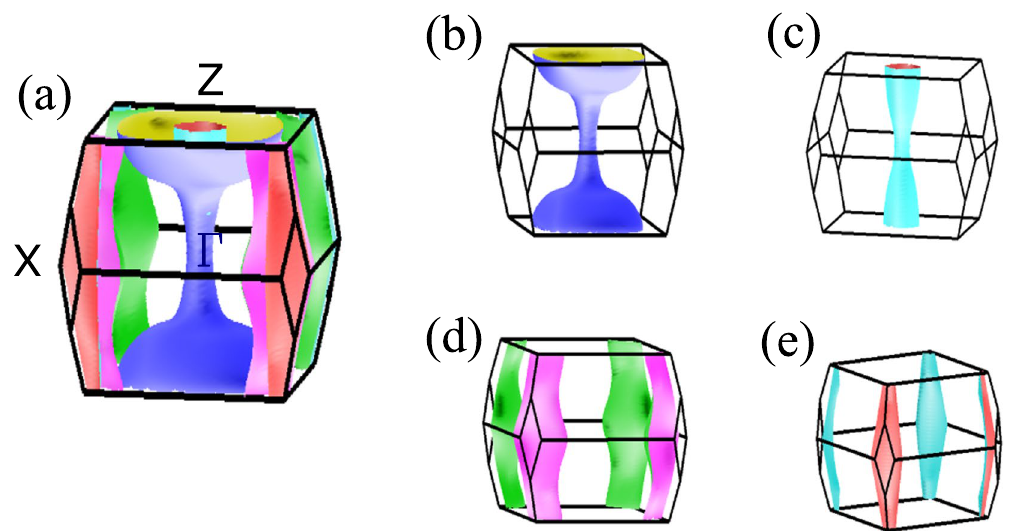
Figure 10. ( a ) Fermi surface in the tetragonal phase with relaxed z As (~0.353); for better clarity in the demonstration of the Fermi sheets, the individual Fermi sheets are shown in ( b – e